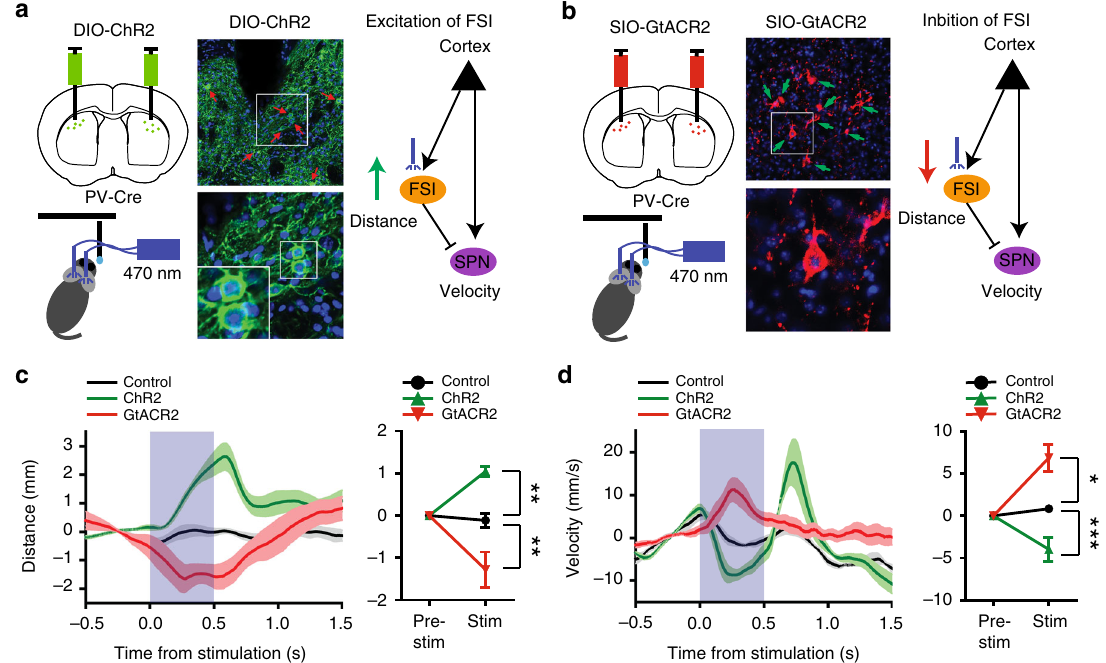
Fig. 6 Optogenetic manipulation of FSI activity disrupts pursuit performance. a We injected Cre-dependent excitatory channelrhodopsin (AAV-EF1a-DIO- ChR2-EYFP) into the sensorimotor striatum of PV-Cre mice. Middle, GFP staining showing FSIs infected with ChR2. This manipulation is expected to increase FSI activity and reduce target SPN activity. b We injected Cre-dependent inhibitory channelrhodopsin (AAV-hsyn1-SIO-GtACR2-Fusion Red) to reduce FSI activity and increase target SPN activity via disinhibition. c Effect of photo-stimulation on self-target distance. Increasing FSI activity with ChR2 increased distance, whereas decreasing FSI activity with GtACR2 decreased distance (repeated measures two-way ANOVA, Interaction: F 2, 11 = 12.68, p